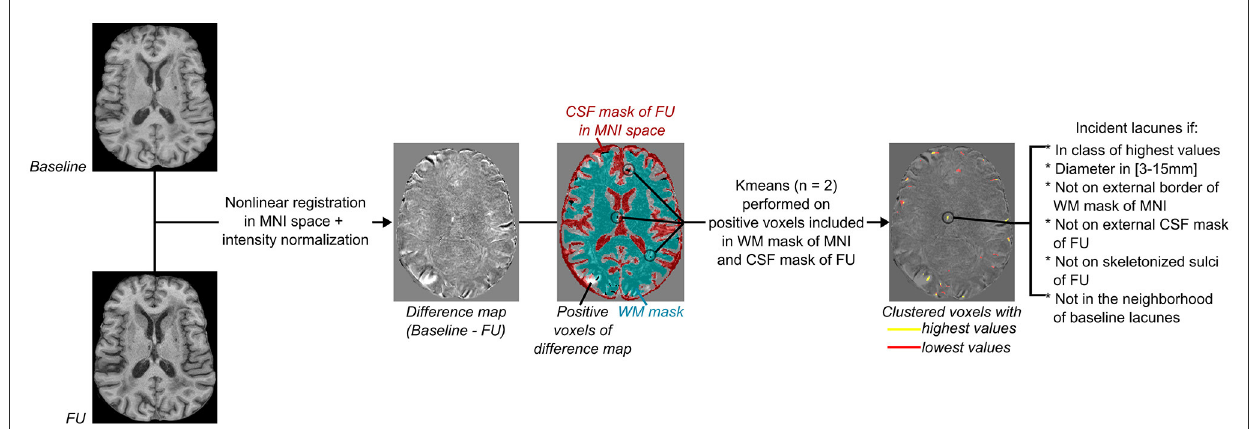
FIGURE2 Flowchart of incident lacunes segmentation. From left to right: Both baseline and follow-up (FU) MRI were non-linearly registered in the MNI space (18, 20), normalized in intensity with FSL tools (https://fsl.fmrib.ox.ac.uk/fsl/fslwiki/), and then subtracted from each other to provide a difference map. As incident lacunes should appear with an MRI signal lower than non-lesioned cerebral matter, with an intensity close to the CSF signal of the FU MRI, only voxels of the difference map with a positive value and superimposed to the registered CSF mask of FU MRI were considered (refer to Figure 1A). Only clusters included in the cerebral white matter (WM) were kept, and their mask was defined on the MNI template (refer to Figure 1B). A K-means clustering with two classes was then performed on voxels considered likely lacunes and distinct from noise. The difference map was thresholded using the minimal value of the clustered class with the highest values. Only groups of voxels of diameter between 3 and 15mm, not superimposed to the border of the WM MNI mask (refer to Figure 1B), to the external CSF mask (included in the subarachnoid space), or to the skeletonized sulci of FU MRI (refer to Figure 1A) were considered. Finally, clusters in the neighborhood of baseline lacunes were labeled separately from “incident”